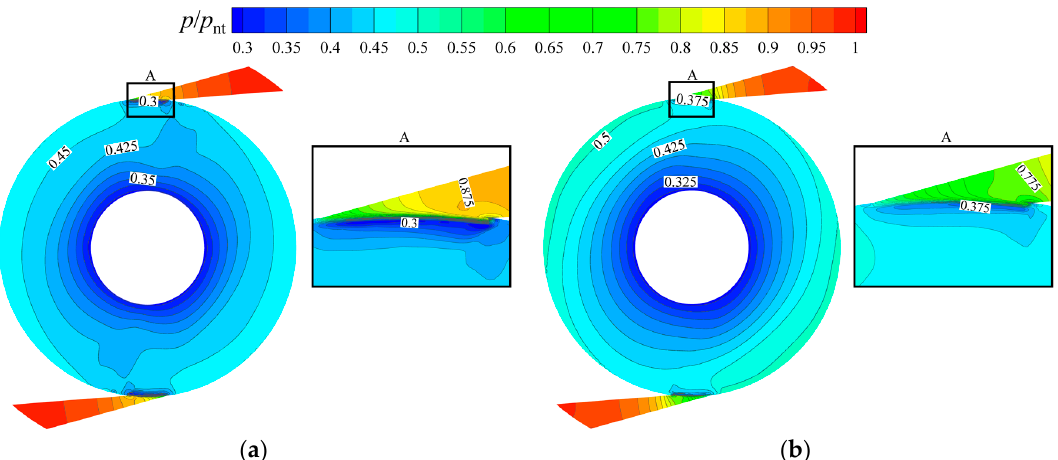
Figure 13. Contours of pressure ratio on the mid-sections of DC1 for the one-to-many Tesla turbine cases with different disc thickness at 30,000 r/min: ( a ) Case 1-0.5; and ( b ) Case 2-0.5.